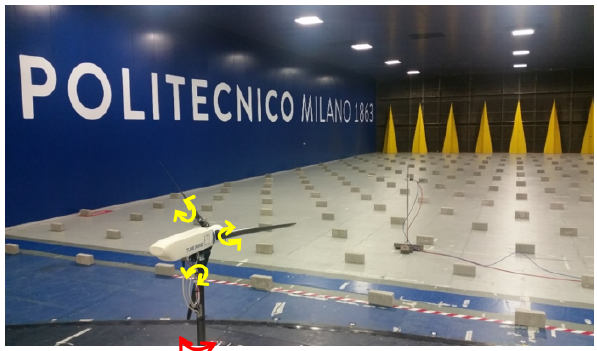
Figure 4. A G1 scaled wind turbine model within the wind tunnel of the Politecnico di Milano. The yellow and red arrows show the pitch and yaw control possibilities, respectively. The yellow spires and bricks in front of the model create the high-TI flow conditions.